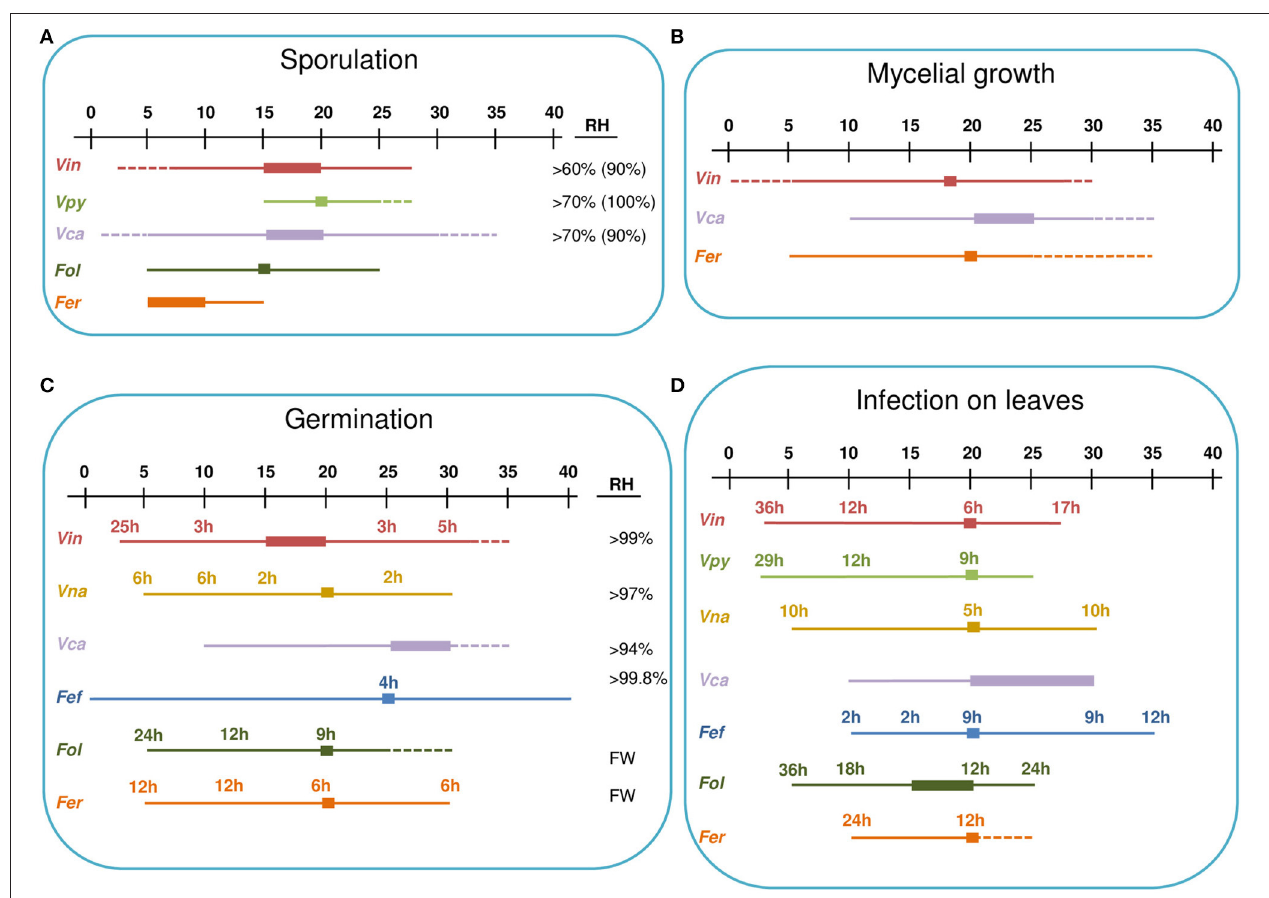
FIGURE 4 | Environmental requirements of Venturia spp. for sporulation (A) , mycelial growth (B) , germinacion (C) , and leaves infection (D) . A temperature scale from 0 to 40 ◦ C is indicated at the top of each panel. Thin lines indicate the temperature at which the different processes occur for each species. Thick lines indicate optimal temperatures. Dotted lines indicate temperatures that are known not to support the process based on experimental evidence. Numbers indicate the hours of wetness necessary at each temperature. For sporulation (A) , the RH range in which the process can occur is indicated, with the optimal RH in brackets. For conidial germination (C) , the RH range in which the process can occur is indicated; FW indicates that free water is required for germination. Fef, Fusicladium effusum ; Fer, Fusicladium eriobotryae ; Fol, Fusicladium oleagineum ; Vca, Venturia carpophila ; Vin, Venturia inaequalis ; Vna, Venturia nashicola ; Vpy, Venturia pyrina